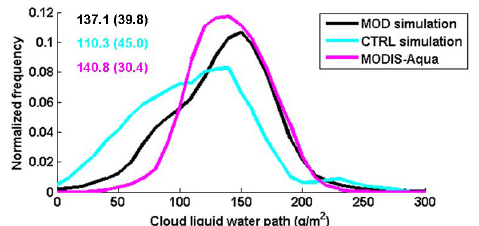
Figure 13. Comparison of total TOA fluxes (Wm − 2 ) with obser- vations from the CERES sensor onboard the Aqua satellite. The histograms are computed over the entire study area and for the JJA months. The median and standard deviation (in brackets) values are shown for all cases.